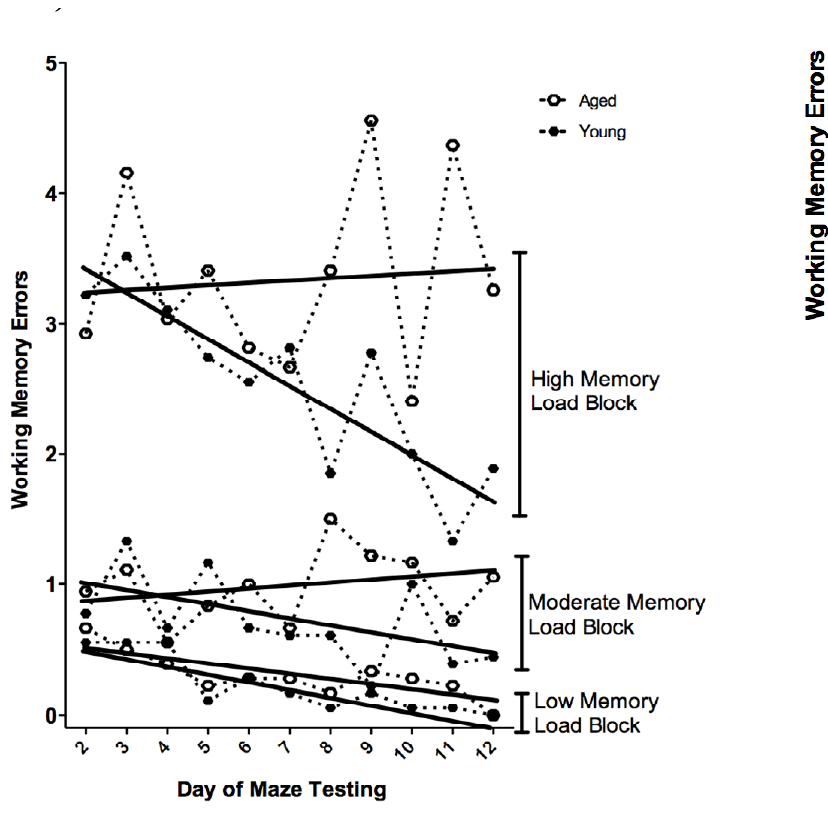
Figure 2. Age alters the ability of animals to handle an increasing working memory